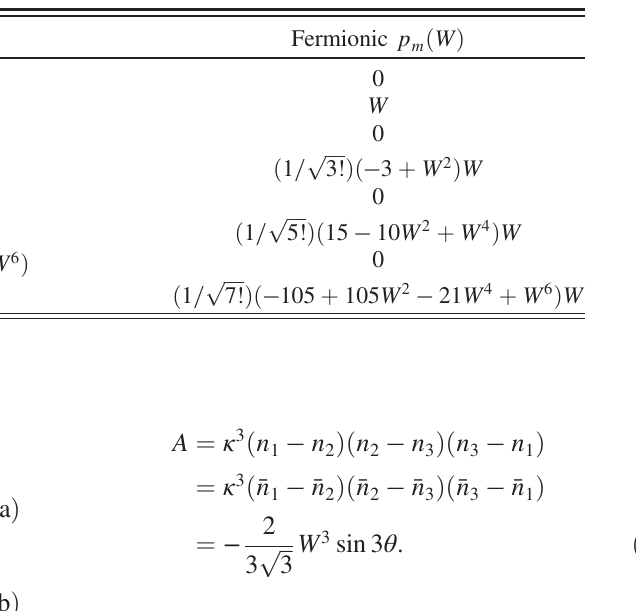
TABLE II. Representative polynomials p m for the first few N ¼ 2 -body PPs for bosons and fermions. W Þ e − W 2 = 4 represents the probability amplitude that two particles W= κ sites apart along a chain are involved p m ð in a two-body